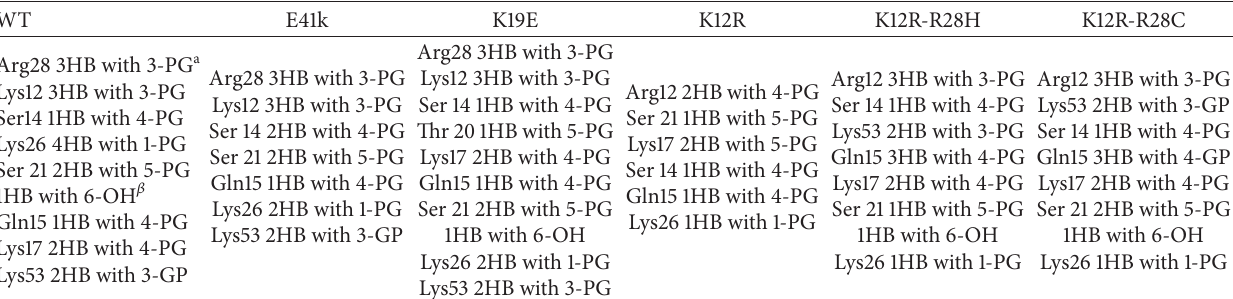
a HB and PG represent hydrogen bond and phosphate group, respectively. 𝛽 OH represents OH group in the inositol ring.